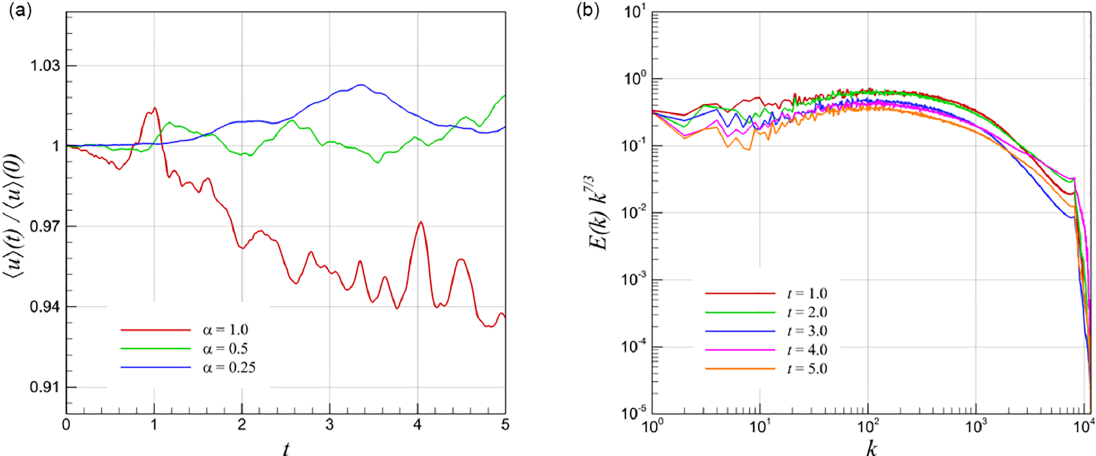
Figure 5. Time evolution of 2-D KHI turbulence field characteristics with a resolution of N 2 = 16384 2 , showing normalized root mean square values of velocity u for various α values (a) , and compensated energy spectra computed from u at various times for α = 1 . 0 (b)